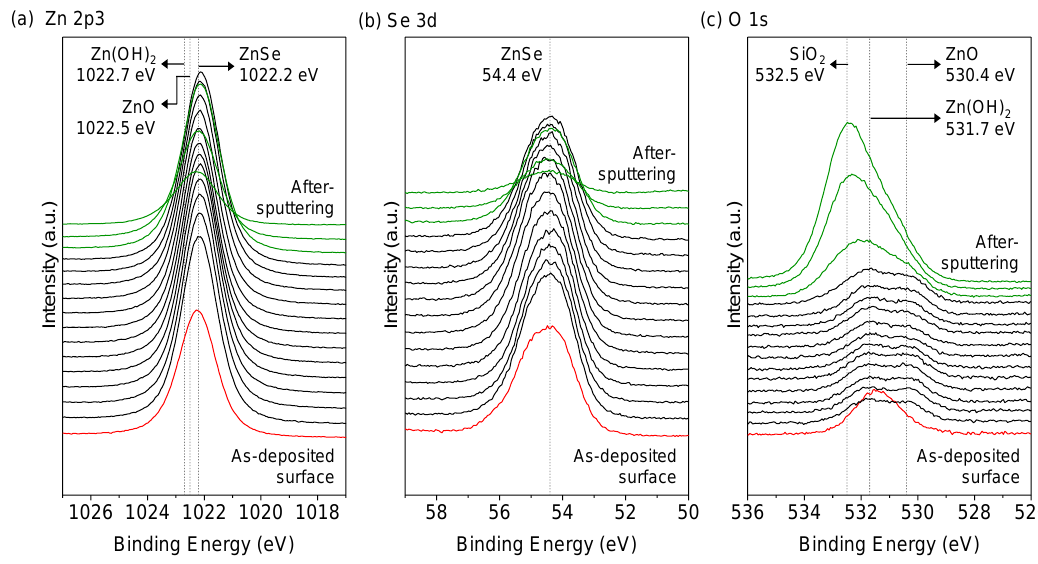
Figure 7. Montage of photoelectron binding-energy spectra for the depth profiles of Zn 2p3, Se 3d, and O 1s of a Zn(Se,OH) film, deposited with NH 4 OH concentration of 1.2 M (view with after-sputtering curve in the background).